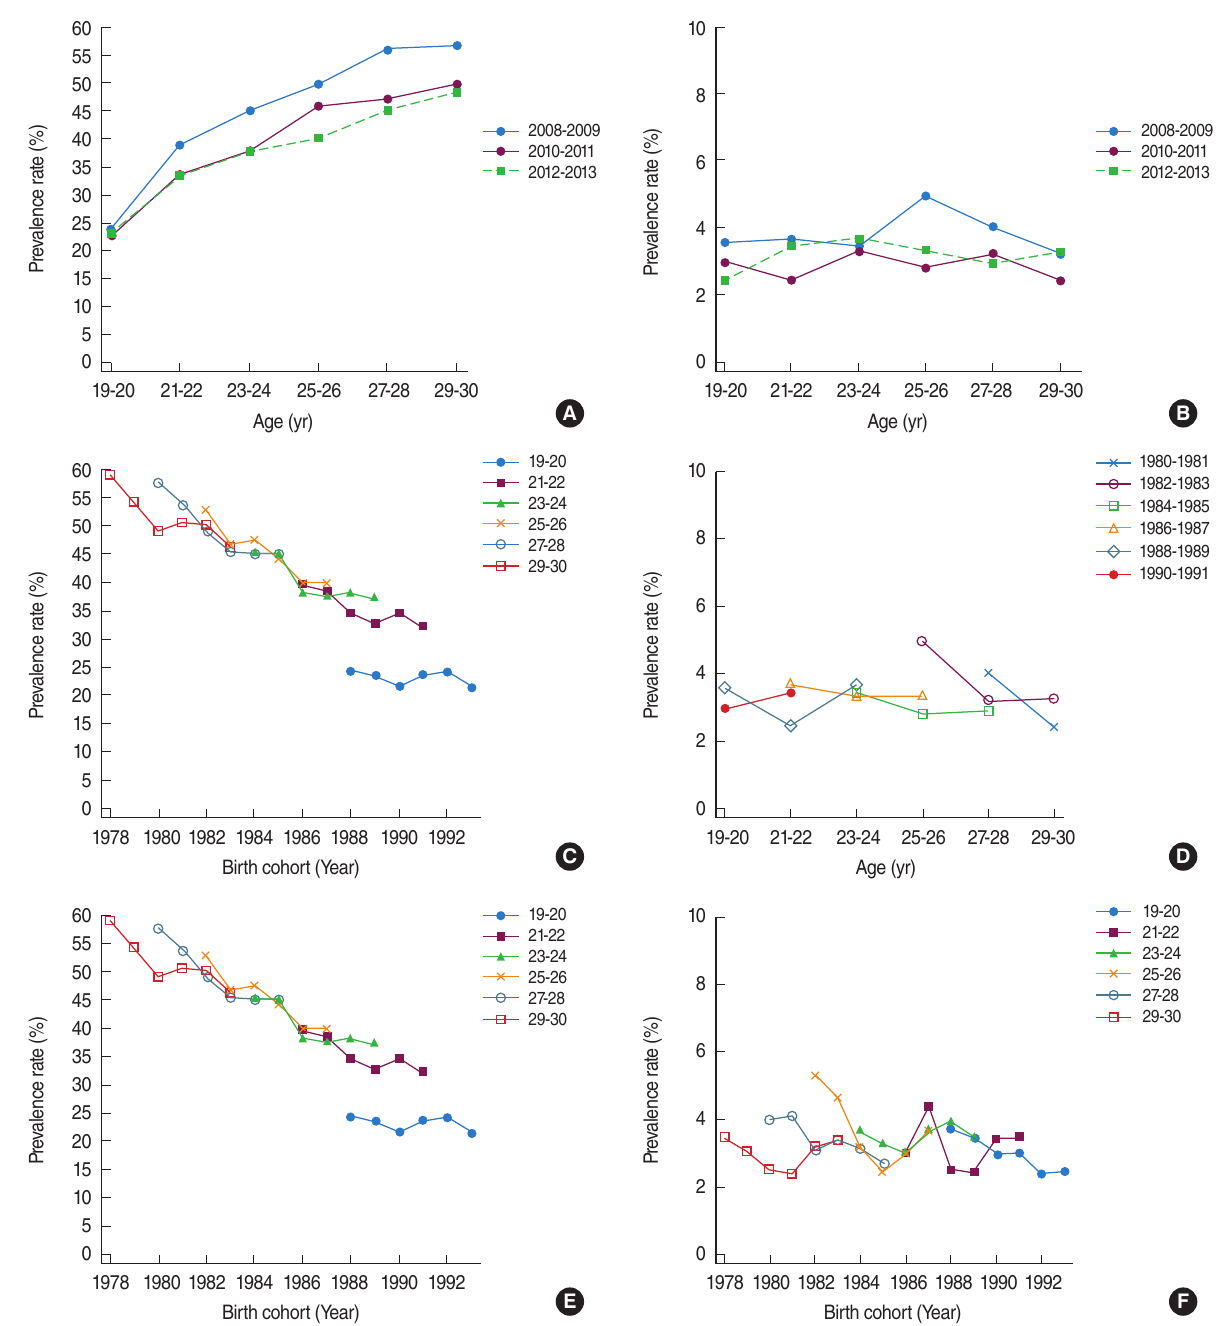
Figure 1. Age-period-cohort effect of age-specific smoking prevalence in 2008 to 2013 in men and women. Age-specific smoking preva- lence by period in men (A) and women (B), age-specific smoking prevalence by birth cohort in men (C) and women (D), and birth cohort- smoking prevalence by age in men (E) and women